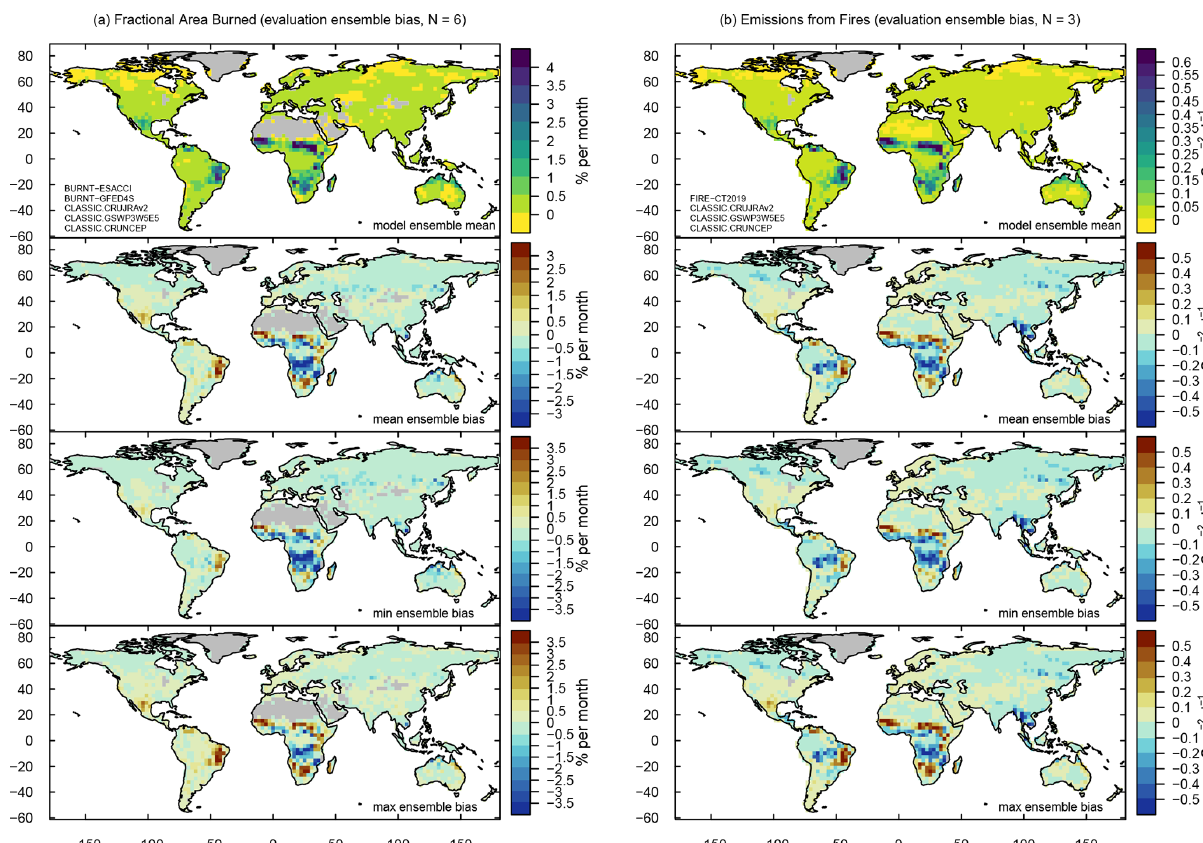
Figure A19. Same as Fig. 7 but for (a) fractional area burned and (b) emissions from